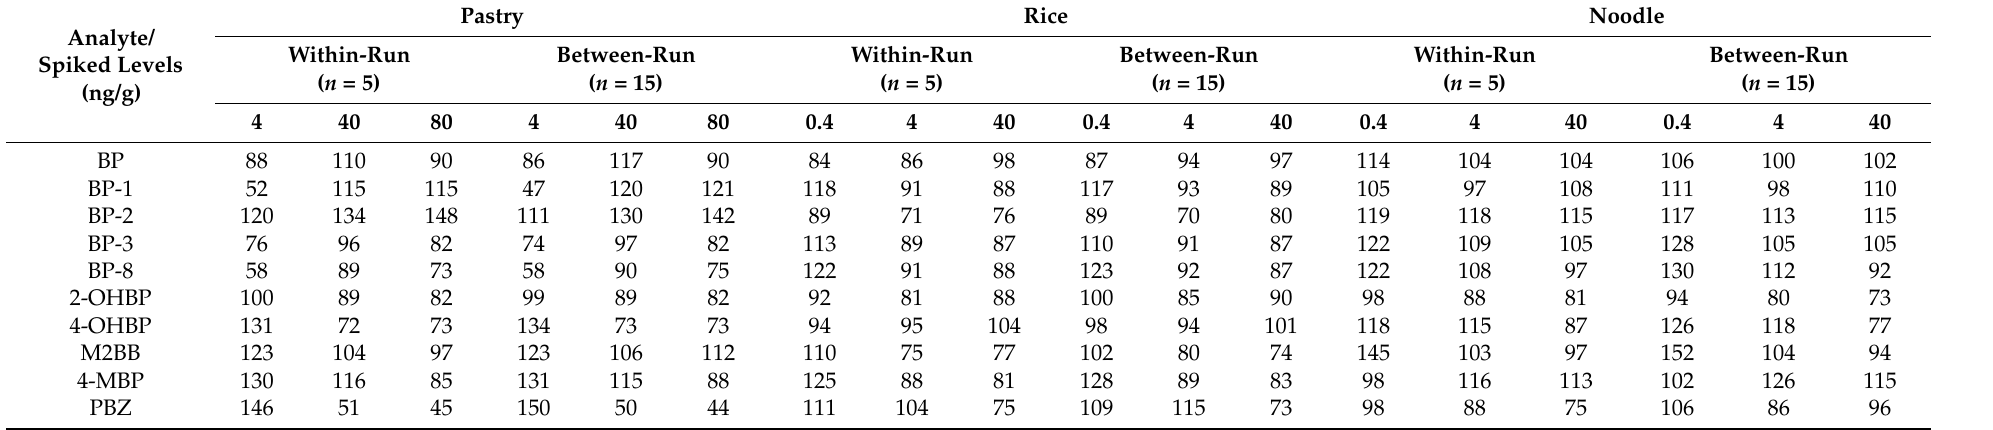
Table 4. Within-run and between-run recoveries in spiked pastry, rice, and noodle samples.